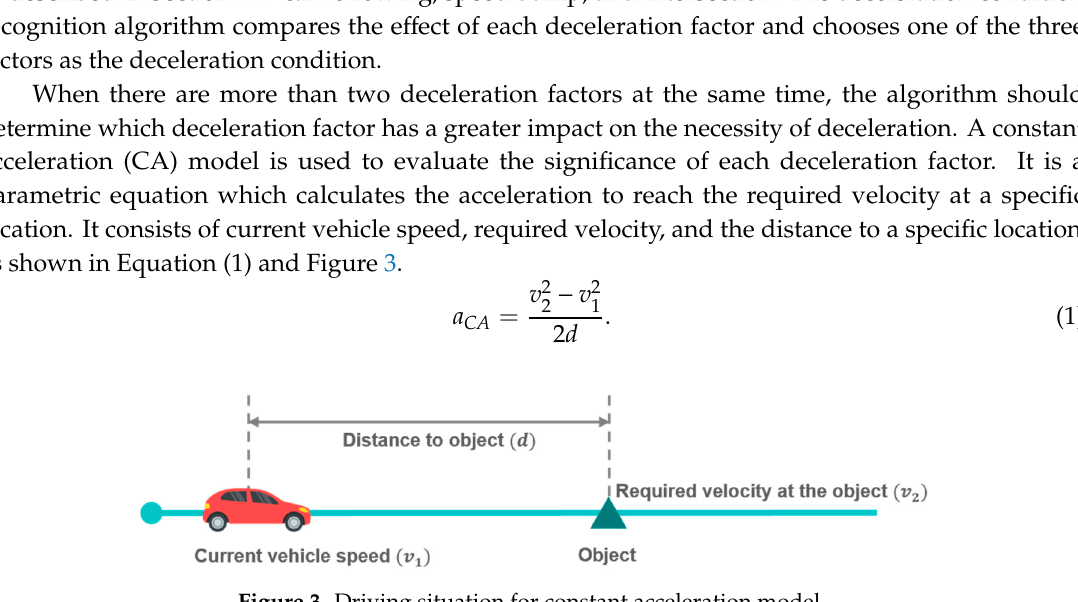
Table 1. Meanings of constant acceleration (CA) model parameters depending on deceleration conditions.